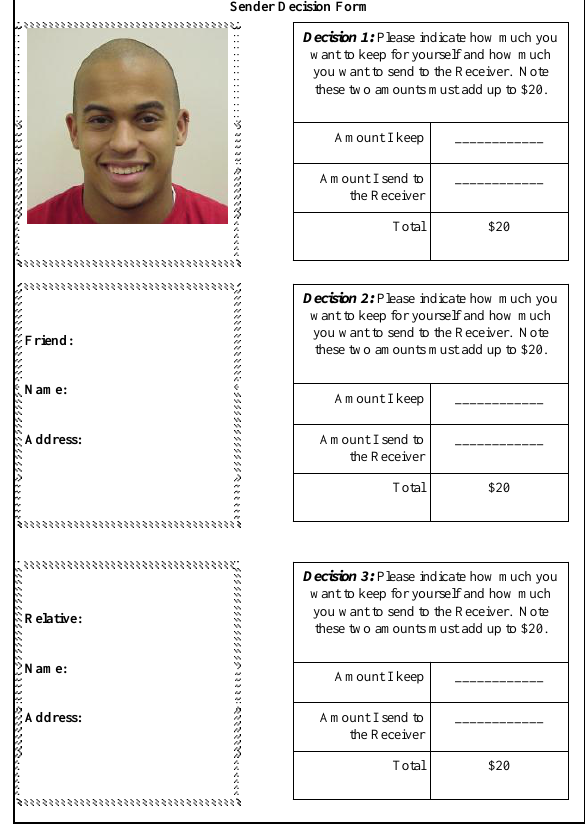
Figure A2. Decision sheet for pilot comparative dictator game.